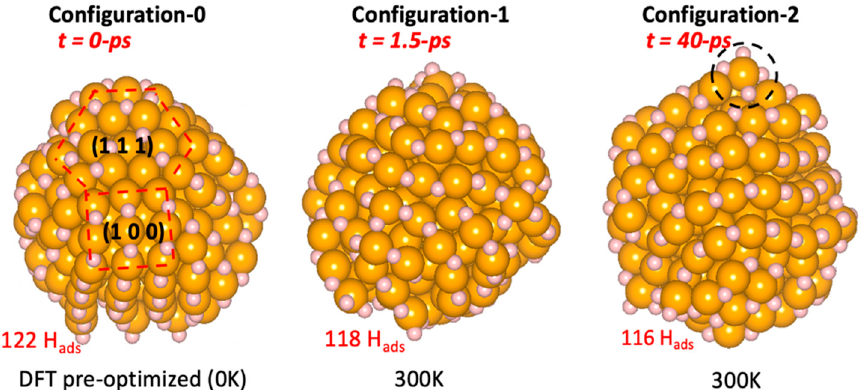
Figure 1. Illustration of the drastic changes in Au NPs exposed to hydrogen. Configurations extracted from AIMD simulation at 300 K, at simulation times of 0 ps (Configuration-0) where truncated octahedron initial structure was pre-optimized by DFT, 1.5 ps (Configuration-1), and 40 ps (Configuration-2). Color coding of atoms: gold in yellow and hydrogen in white. The number of adsorbed hydrogen H ads is indicated in red.